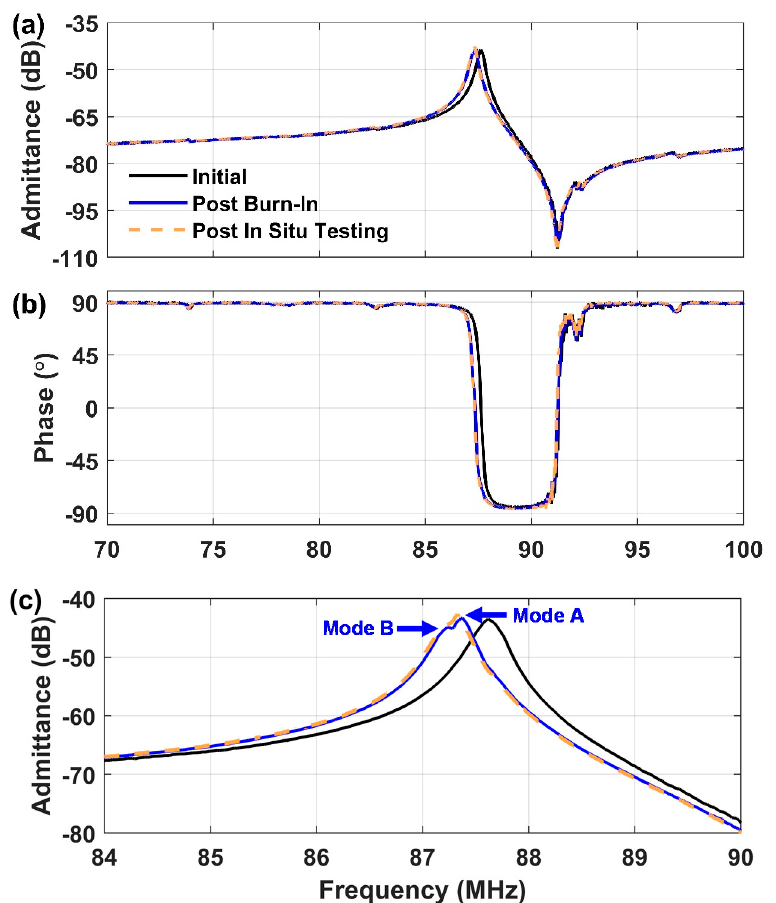
Figure 4. Measured amplitude ( a ) and phase ( b ) of the admittance of the LN MEMS LVR array at 25 °C initially, post burn-in, and post in situ testing up to 500 °C and back. Amplitude zoomed in around resonance and modes A and B in the post burn-in spectrum are labeled ( c ). Table 2. Extracted key parameter values initially, post burn-in and post in situ testing as shown in Figure 4.